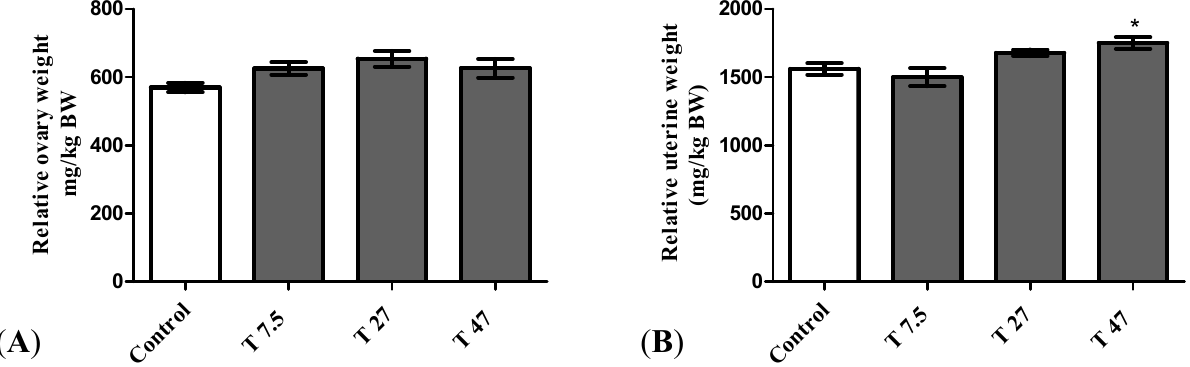
Figure 3. Effect of tartrazine on the relative weight of ovaries ( A ) and uterus ( B ) of immature female Wistar rats after 40 days of treatment. Control = animals receiving vehicle (distilled water, 10 mL/kg BW); T = rats treated with tartrazine at doses of 7.5; 27, and 47 mg/kg BW. Results are shown as a mean ± SEM, n = 5. *: p < 0.05 in reference to control.